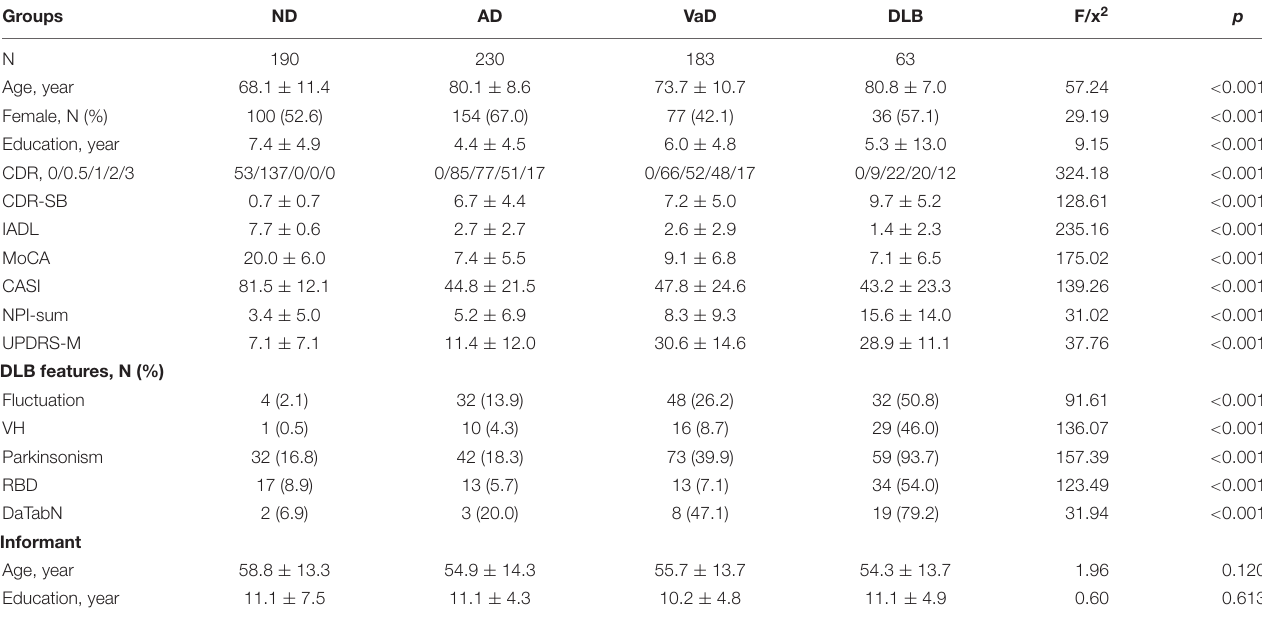
TABLE 1 | Comparison of demographic data among ND, AD, VaD, and DLB groups. Groups